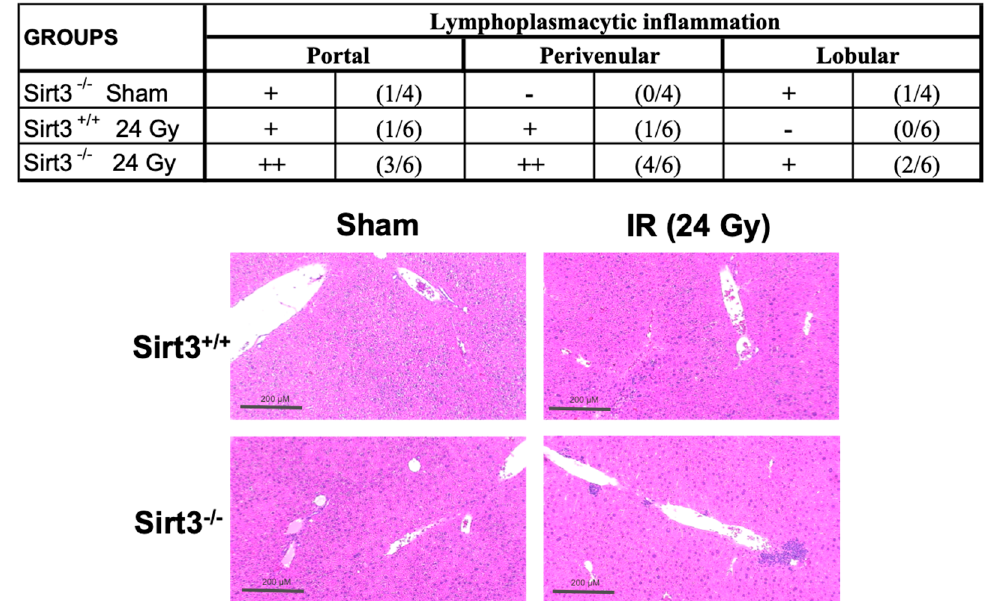
Figure 2. Increased numbers of inflammatory cells were seen in irradiated Sirt3 − / − mice. H&E scoring: − (none), + (mild/focal), and ++ (moderate). All sections were normalized to the Sham Sirt3 +/+ group and presented as number of animals with marker per animals in each group ( n = 4–6). Sham groups underwent the same procedures without receiving 24 Gy IR (irradiation).